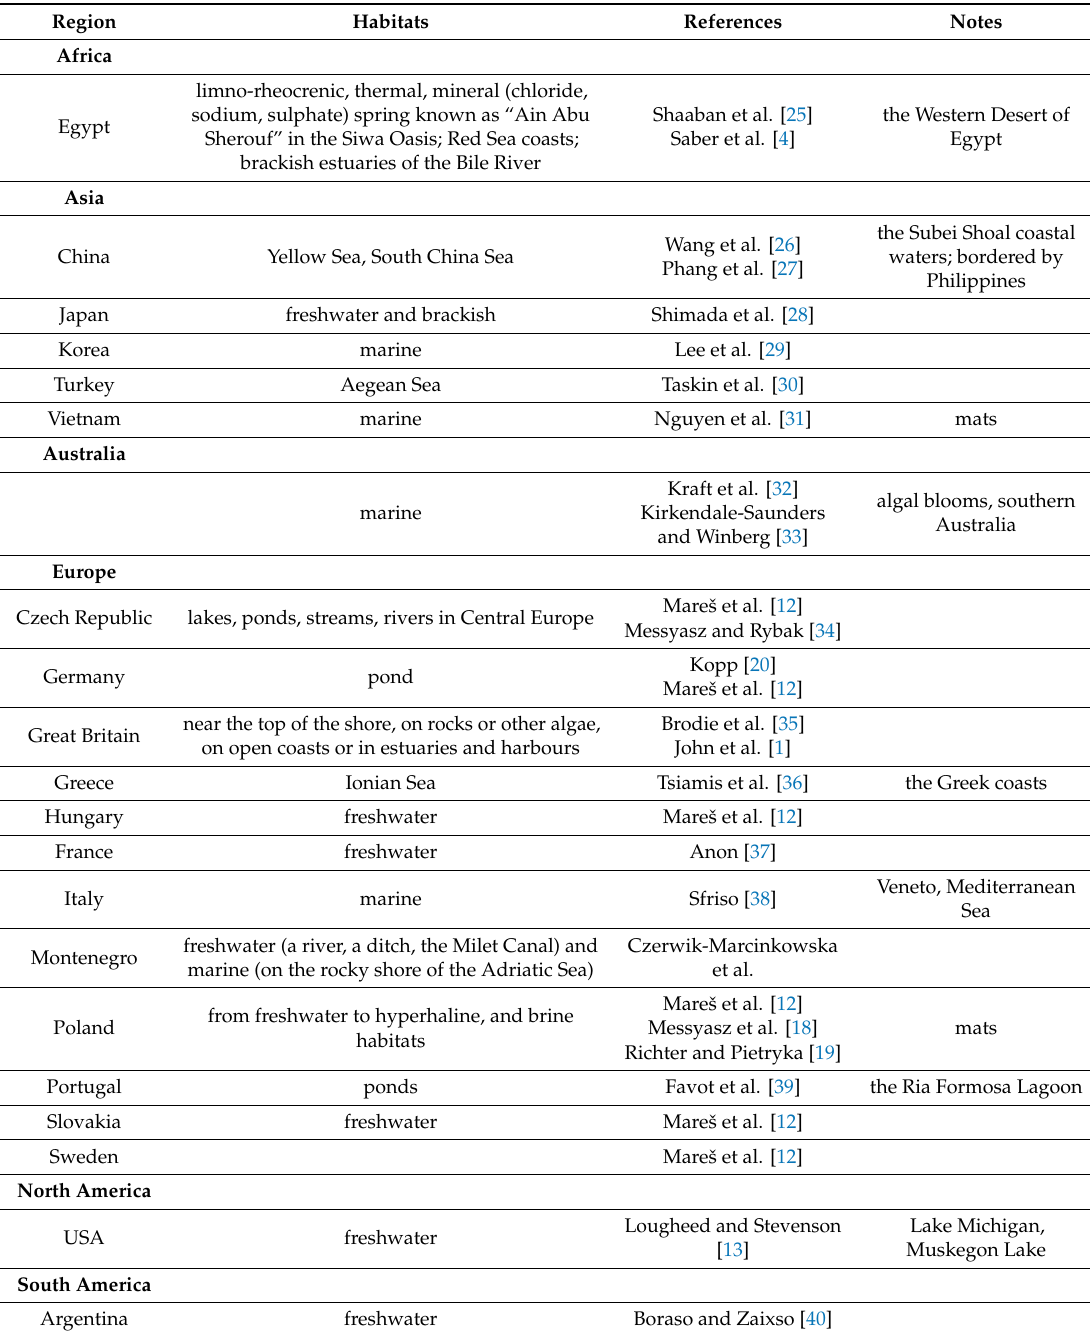
Table 4. Occurrence (in freshwater and marine ecosystems) and habitat preference of Ulva pilifera .